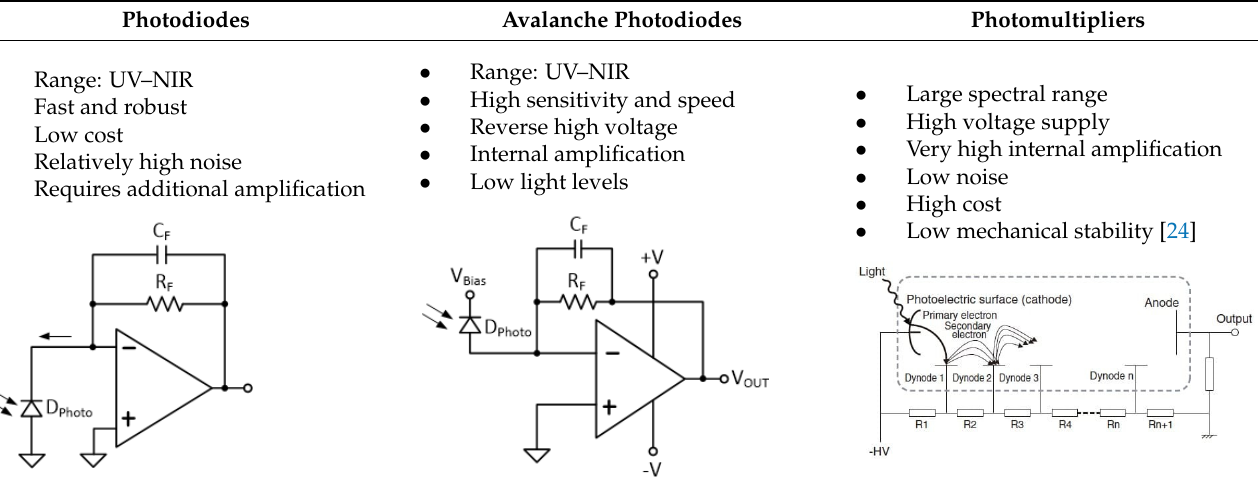
Table 2. The main characteristics of light detectors used for optical sensing.